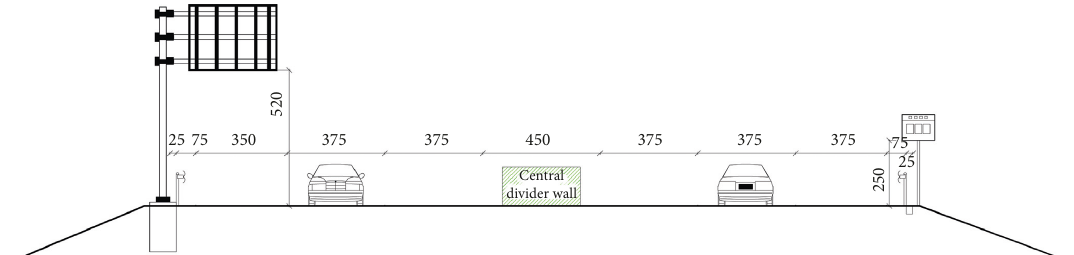
Figure 5: The cross-section of the Hunan section of the Beijing-Hong Kong-Macau Expressway (for details, refer to the text). Table 2: General values of minimum radius [31]. Design speed (km/h)